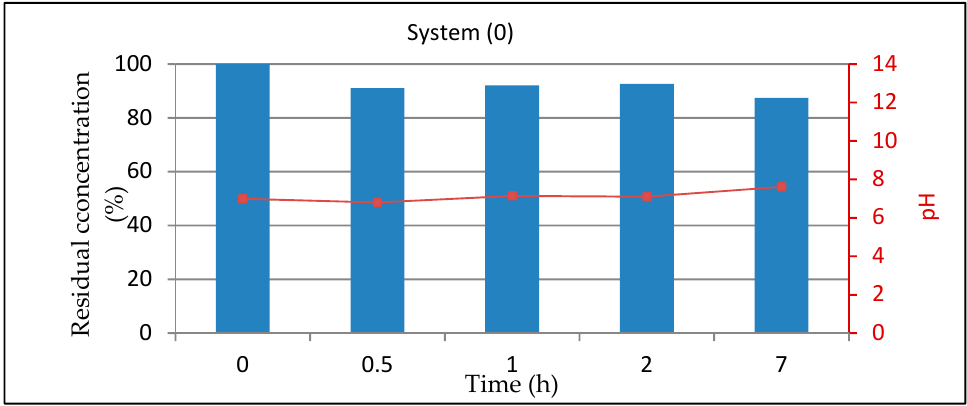
Figure 2. Residual concentration (%) and pH for System 0, as a function of the UV irradiation time exposure.